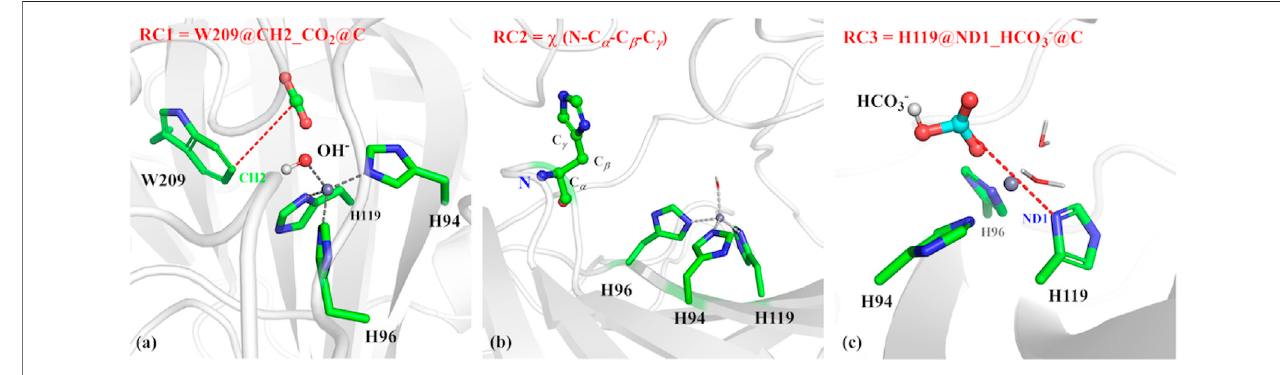
FIGURE 3 | (A) Reaction coordinate (RC1) de fi ned by the distance between CO 2 @C and W209@CH2 for the delivery of CO 2 , (B) Reaction coordinate (RC2) de fi ned as the dihedral angle χ (N – C α – C β – C c ), (C) Reaction coordinate (RC3) de fi ned by the distance between H119@ND1 and HCO 3-